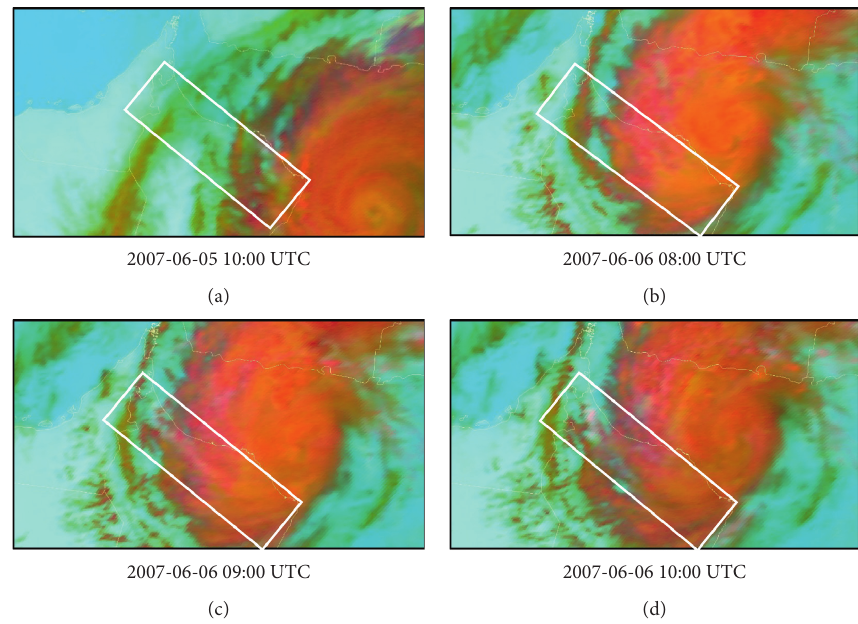
Figure 5: Sequence of day microphysical RGB composition images on 5th and 6th of June. The color scheme is useful to detect cu- mulonimbus (red), optically thick clouds with small ice particles on top (orange), and thin clouds with small ice particles (light green).